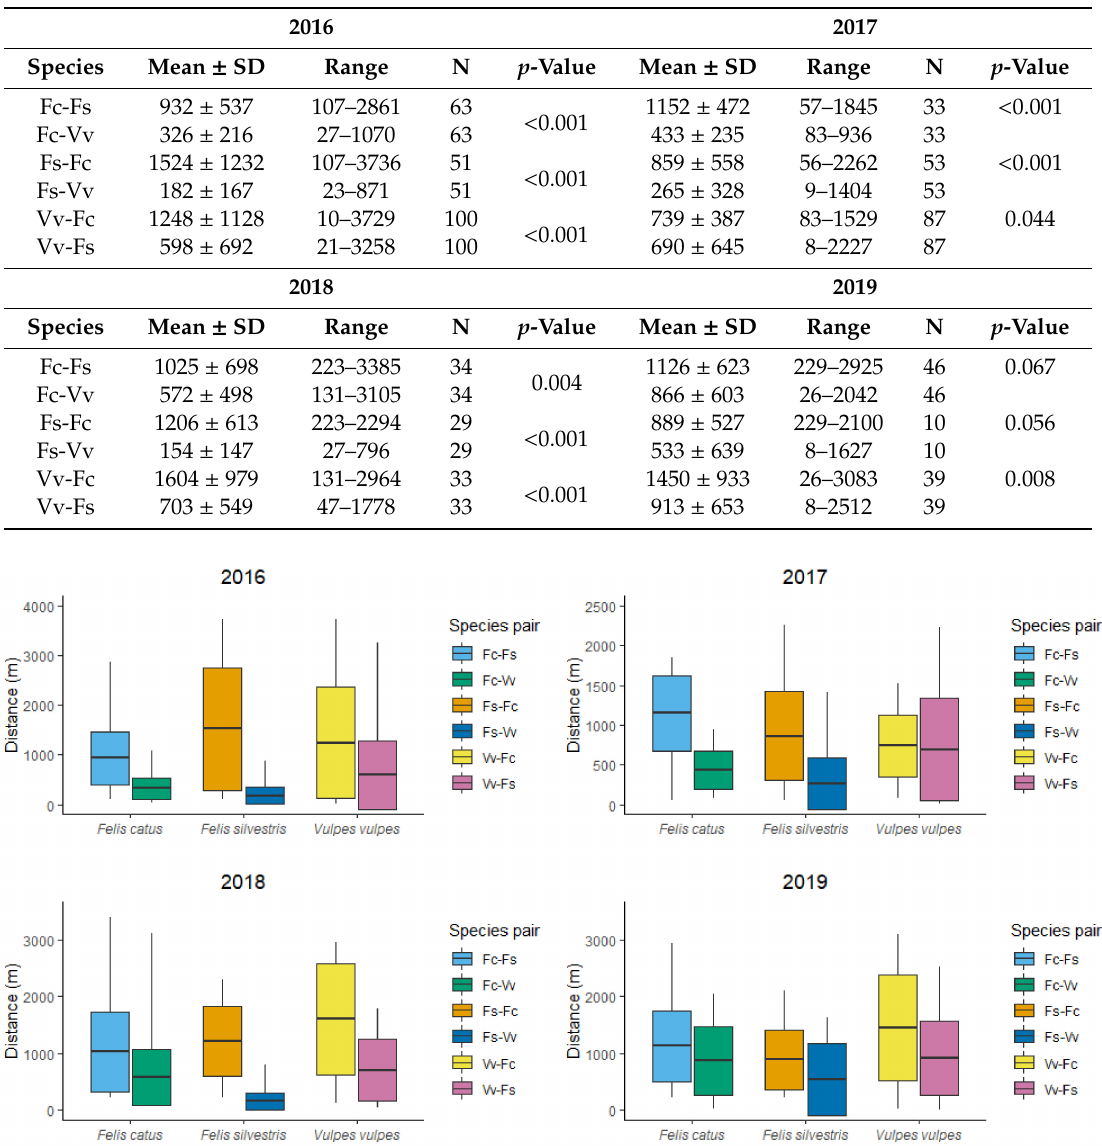
Table 3. Mean closest distance between species observed in pastures. Comparisons were made between pairs of species taking one as a reference: first domestic cat (Fc), second European wildcat (Fs) and third red fox (Vv). p -values are provided for each comparison. All measurements are in meters.